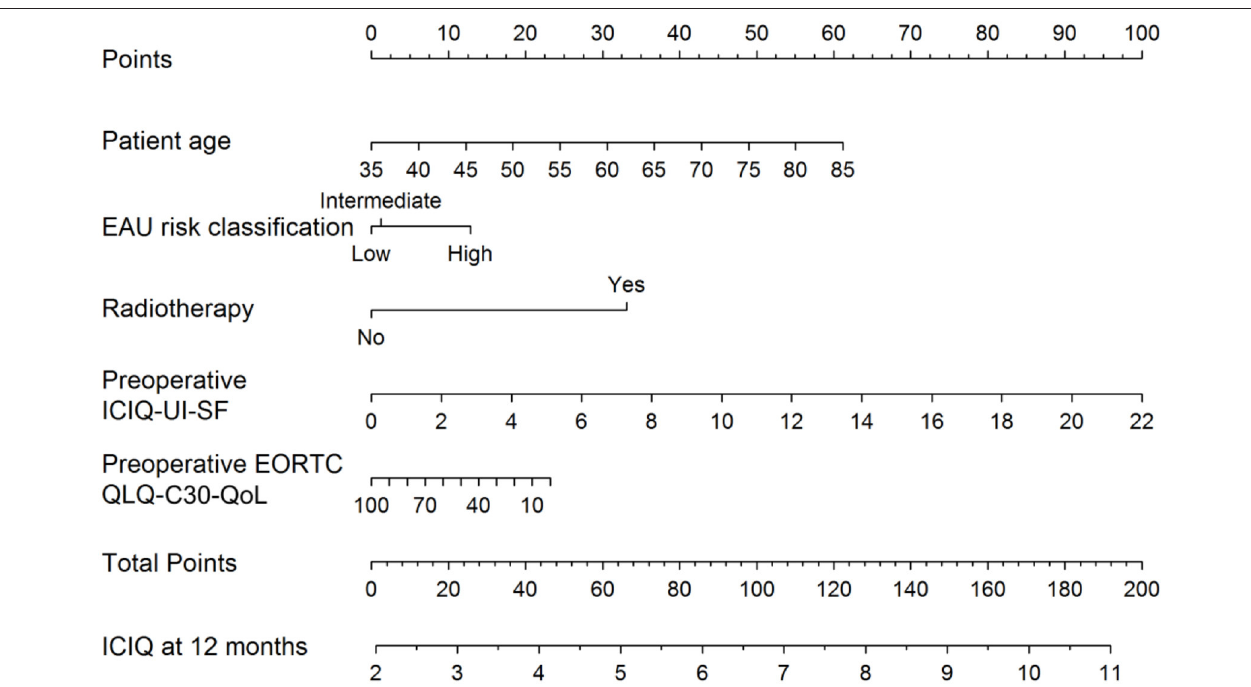
FIGURE 1 | Nomogram for the preoperative prediction of the 12-month ICIQ-UI-SF score among patients diagnosed with prostate cancer and treated with robotic-assisted prostatectomy. Instructions: locate the patient’s values for age, EAU risk classification, baseline EORCT QLQ-C30/QoL and baseline ICIQ-UI-SF on the corresponding axes. Draw a straight line up to the Points axis for each value to determine the number of points for that value. Calculate the sum of the values on the Points axis and locate this sum score on the Total Points axis. Draw a straight line down to find the patient’s predicted ICIQ-UI-SF score at 12 months. From Tutolo et al. ( 44). EORCT QLQ-C30/QoL, European Organization for Research and Treatment for Cancer Quality of Life Questionnaire of Prostate Cancer; ICIQ-UI-SF, International Consultation on Incontinence Questionnaire-Urinary Incontinence Short Form; EAU, European Association of